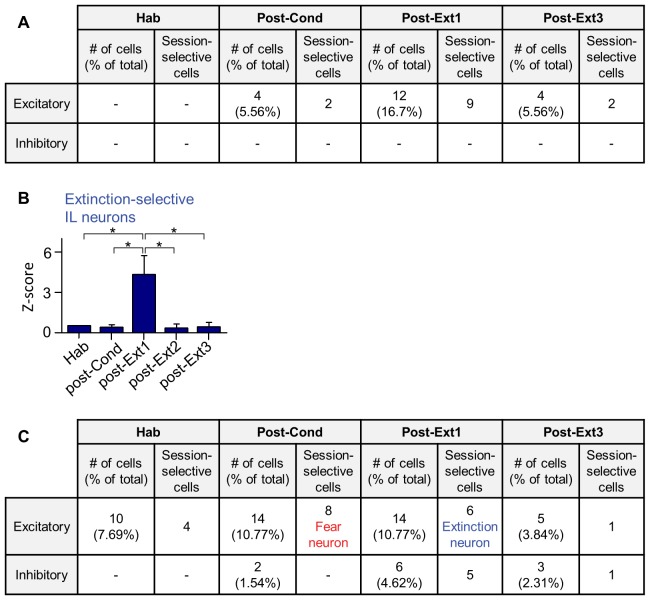
Cell-based analysis of single unit recordings in the IL and Ba.(A) CS-responses in IL individual neurons throughout the training period. The cell-based analysis was conducted by comparing the largest z-values of 0–400 msec following CS onset (bin size, 100 msec). The number of CS-responsive cells and the percentage of total recorded neurons are indicated. Neurons displaying CS-responses only in one particular session were indicated as session-selective cells. (B) Extinction-selective cells in the IL (post-Ext1, n = 9 cells) shown in A (χ2 = 18.19, p=0.0011, *p<0.05 for post-Ext1 vs. the other groups, Friedman test followed by Dunn’s test). These cells were included in the successful extinction recall group in Figure 1 (n = 56 cells from 14 rats). The averaged CS-response latency of IL extinction neurons was 211.1 msec, whereas Ba extinction neurons responded to the CS with much shorter latencies, averaged at 43.33 msec (U = 0.0000, p=0.0016, Mann-Whitney test). (C) CS-responses of Ba neurons throughout the training. The cell-based analysis was conducted by comparing the significance of the CS-responses within 100 msec following CS onset throughout the training period (bin size, 20 msec). Fear neurons and extinction neurons have been indicated in red and blue, respectively.